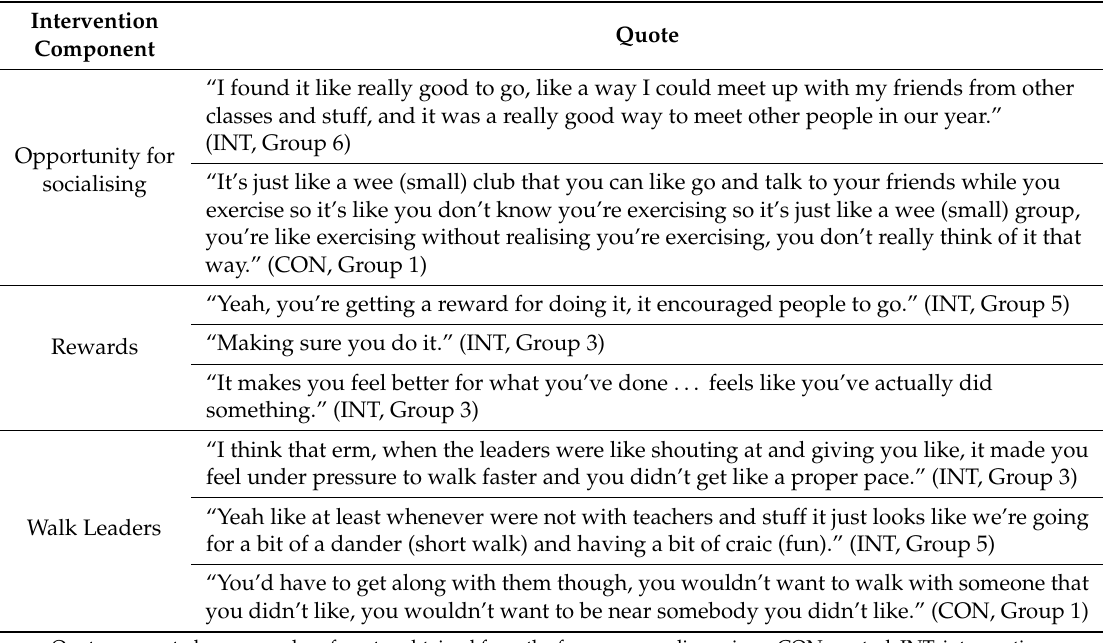
Table 3. Intervention characteristics based on thematic